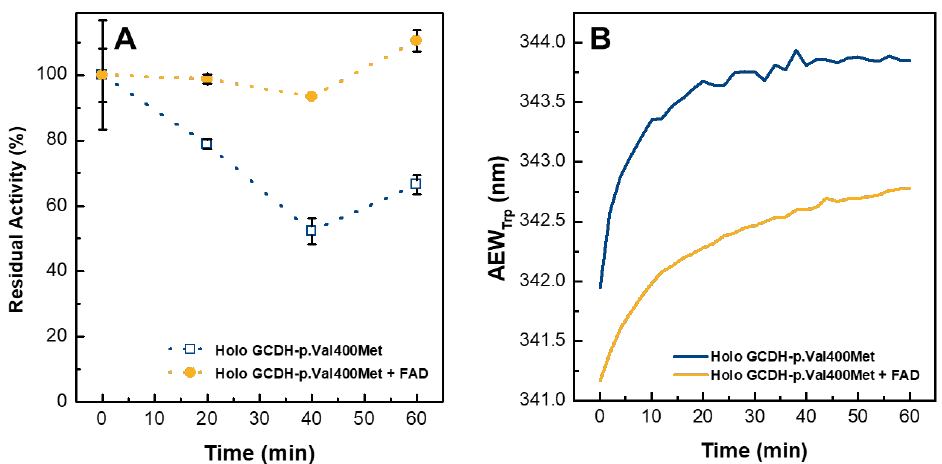
Figure 6. Flavin supplementation rescues activity and kinetic stability of the GCDH-p.Val400Met clinical variant during physiological thermal stress. ( A ) Kinetics of thermal inactivation of holo GCDH-p.Val400Met in the absence (blue, open squares) and presence (yellow, closed circles) of 2.5-fold excess of FAD. The proteins were incubated for up to 1 h at 39 °C, and samples were drawn every 20 min to measure the catalytic activity. The standard deviation corresponds to n ≥ 2 replicates. ( B ) Effect of external flavin on the loss of tertiary structure. Tryptophan emission spectra recorded every 2 min between 300 to 400 nm during 1 h at 39 °C. Average emission wavelength (AEW), which takes into consideration variation in fluorescence intensity and changes in emission maxima, was plotted as a function of time.